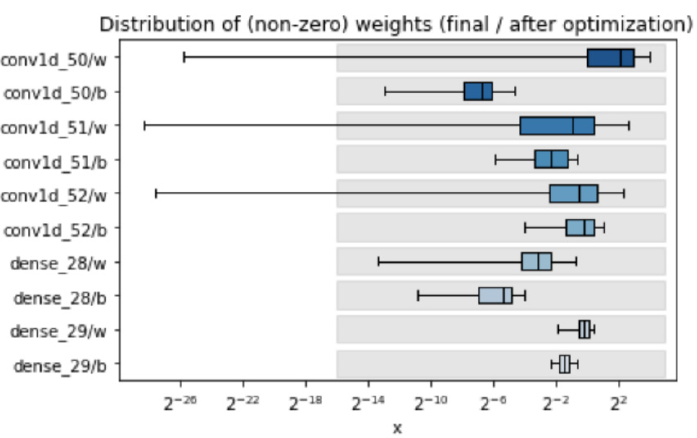
Figure 10. Bit selection using numerical profiling.